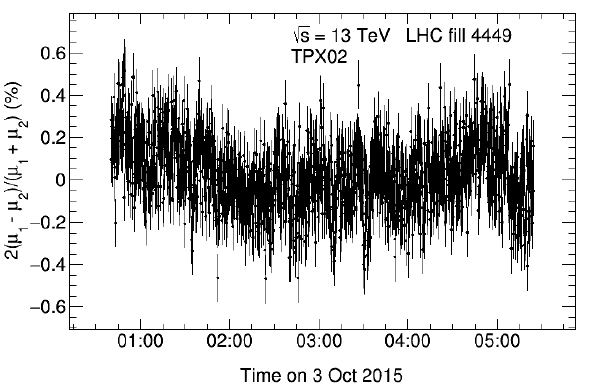
Figure 41. Relative difference between the average number of interactions per bunch crossing measured by layers 1 and 2 of TPX02 as a function of time. The data are shown for 10 frames (1s each) combined in order to decrease the statistical uncertainty. LHC fill 4449. Taken from Ref. [14].